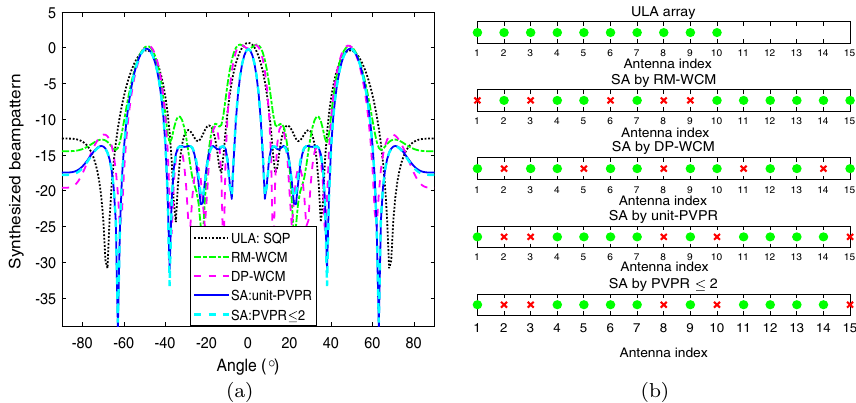
Fig. 3 a Synthesized focused beampatterns with different methods; b Antenna locations, where red crosses denote the discarded antennas and green solid circles the selected